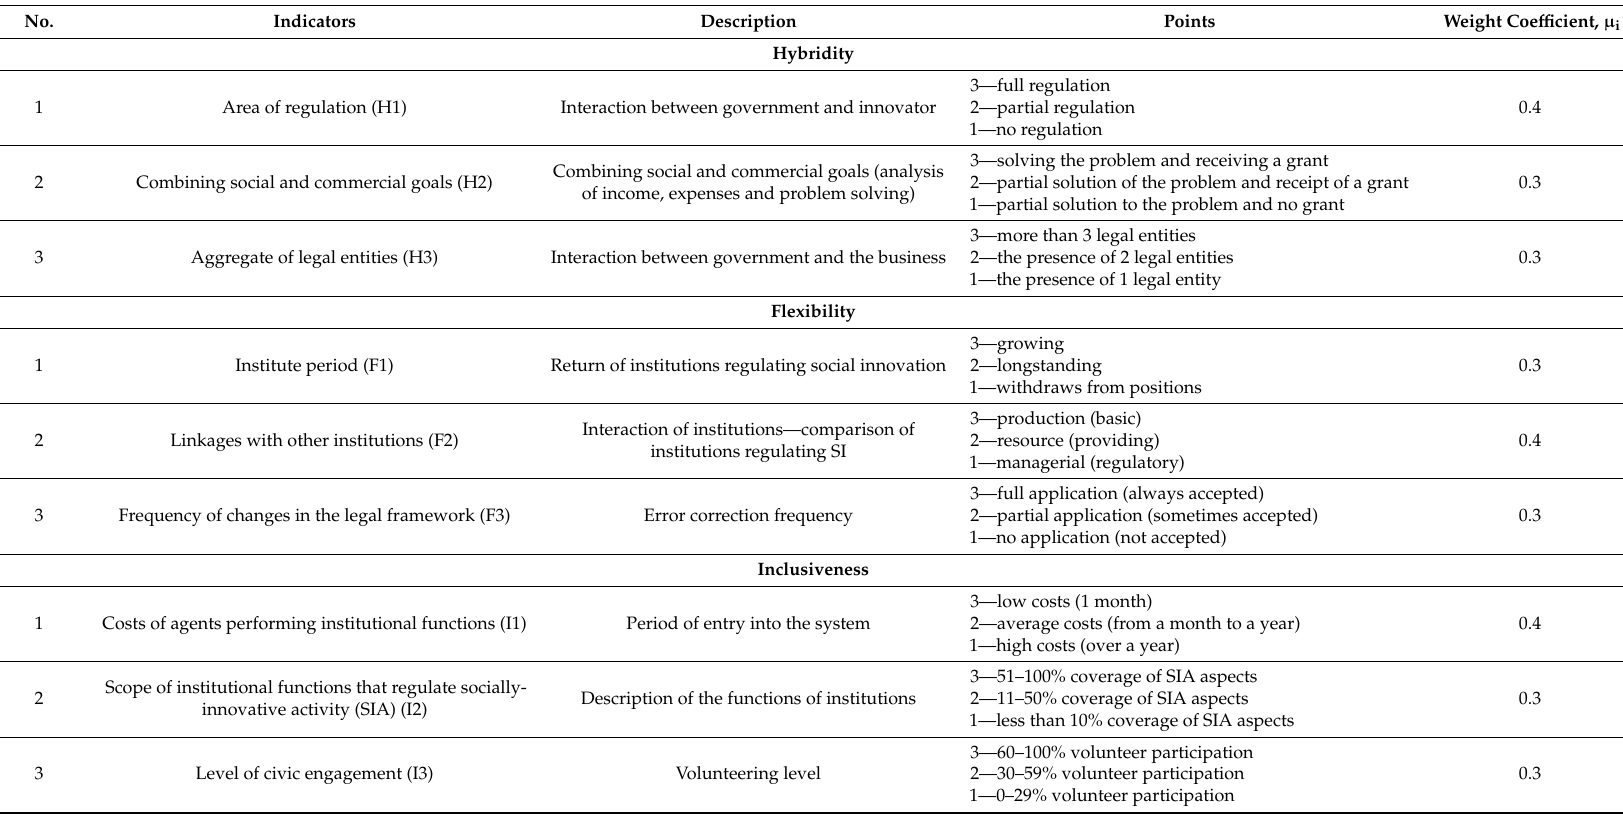
Table 4. Criteria for assessing the institutional